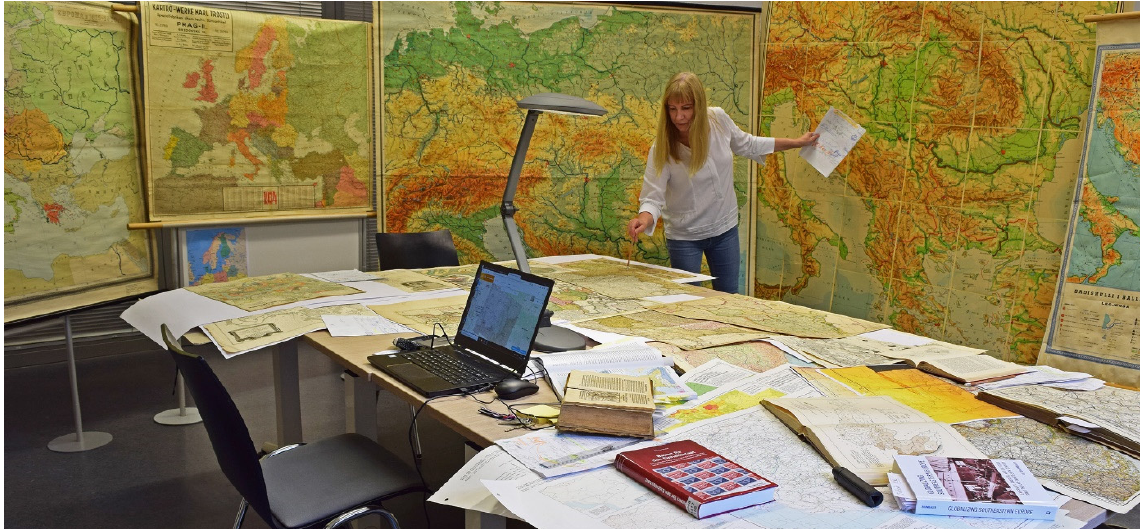
Figure 2. Physical dimension of the Realm of Maps —the workroom with a large table with maps, atlases, books, photographs, a notebook, and wall maps.